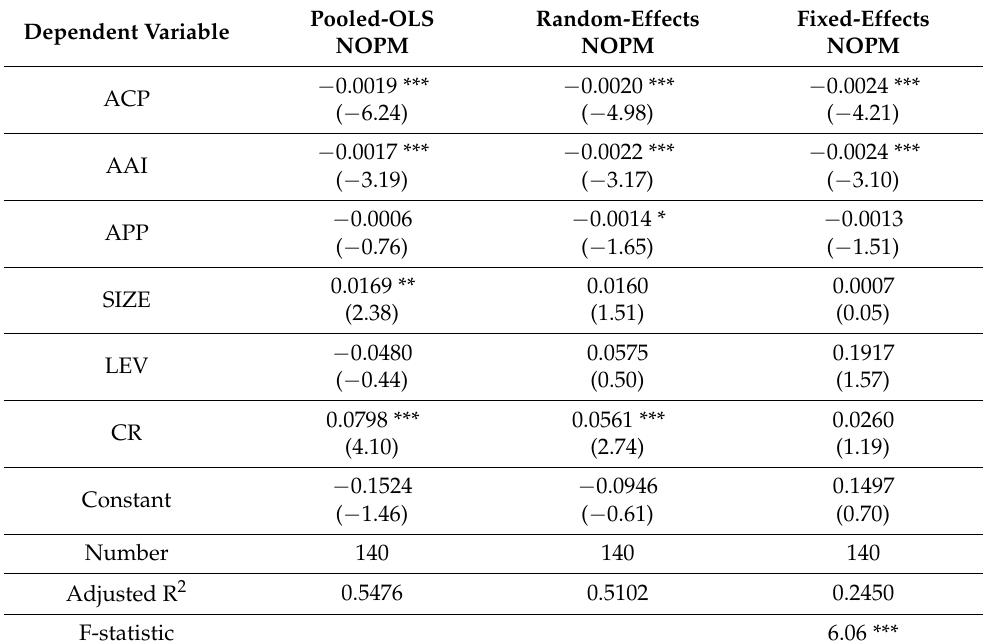
Table 3. Panel regression results with NOPM ratio as the dependent variable. Dependent Variable